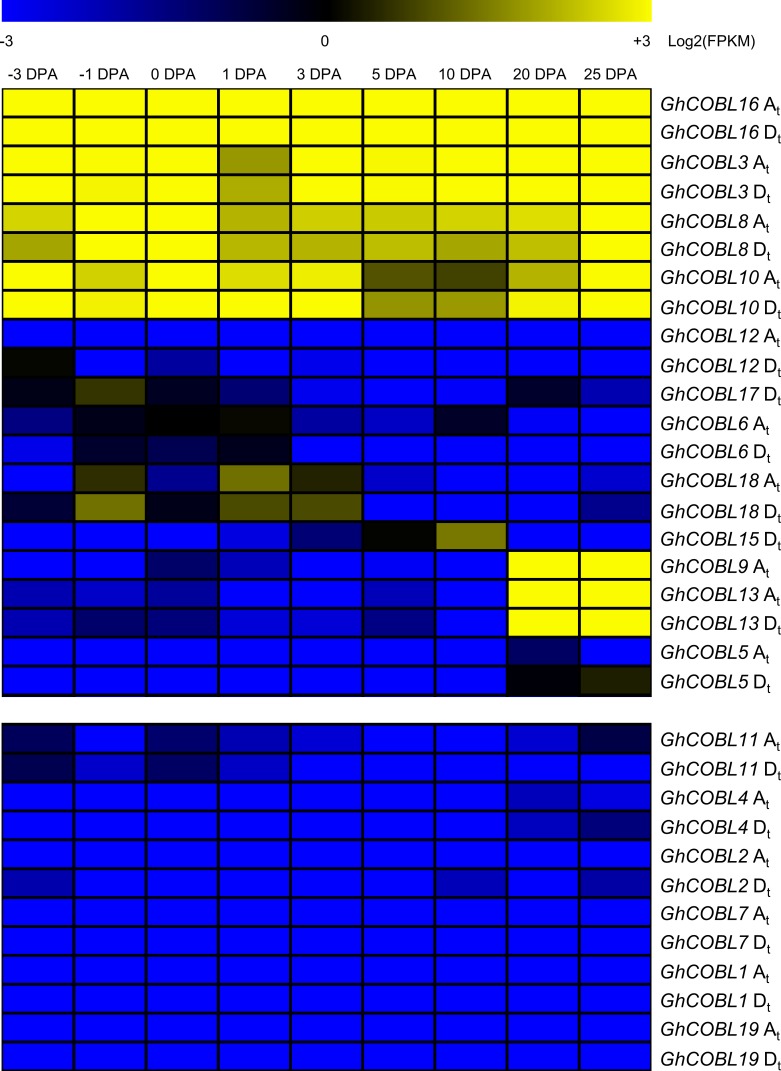
Heat map of the COBLs expression during the fiber developmental stages of G. hirsutum acc. TM-1.The fiber developmental stages involved in initiation (from -3 DPA to 0 DPA), elongation (from 0 DPA to 10 DPA) and secondary wall biosynthesis (from 20 DPA to 25 DPA) were sampled for detecting the expression levels of COBL genes during the fiber development. The relative expression levels were shown as Log2 (FPKM). At and Dt were derived from the A-genome and D-genome progenitor in the tetraploid cotton.